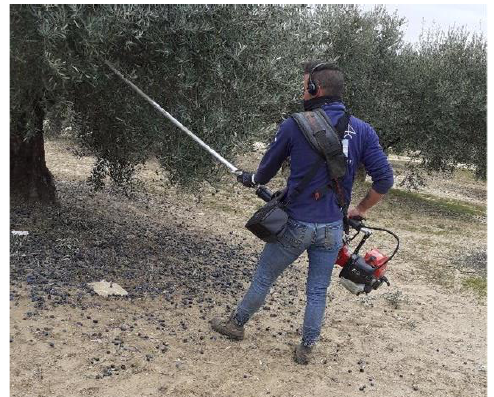
Figure 6. Worker equipped with hook type olive harvesters and measurement sensors.